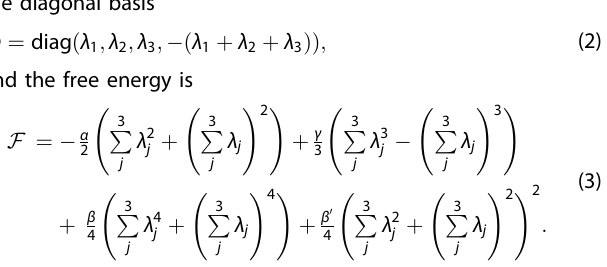
ffiffiffiffiffiffiffiffiffiffiffiffi p 3 = 16 y , F iii is